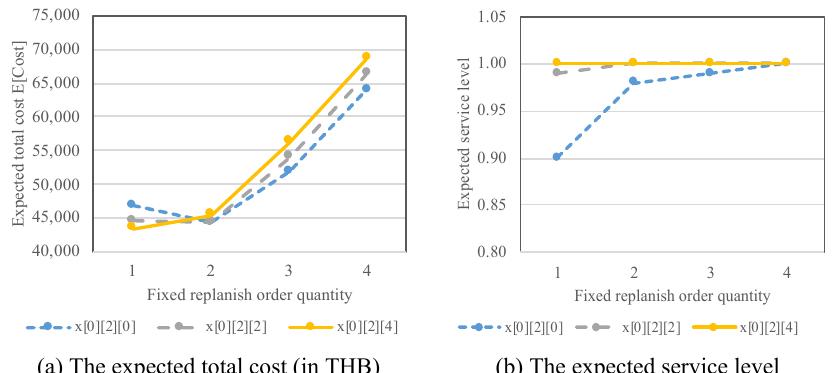
Fig. 8. Comparison of the total expected cost (in THB) and the expected service level under each fixed replenishing order